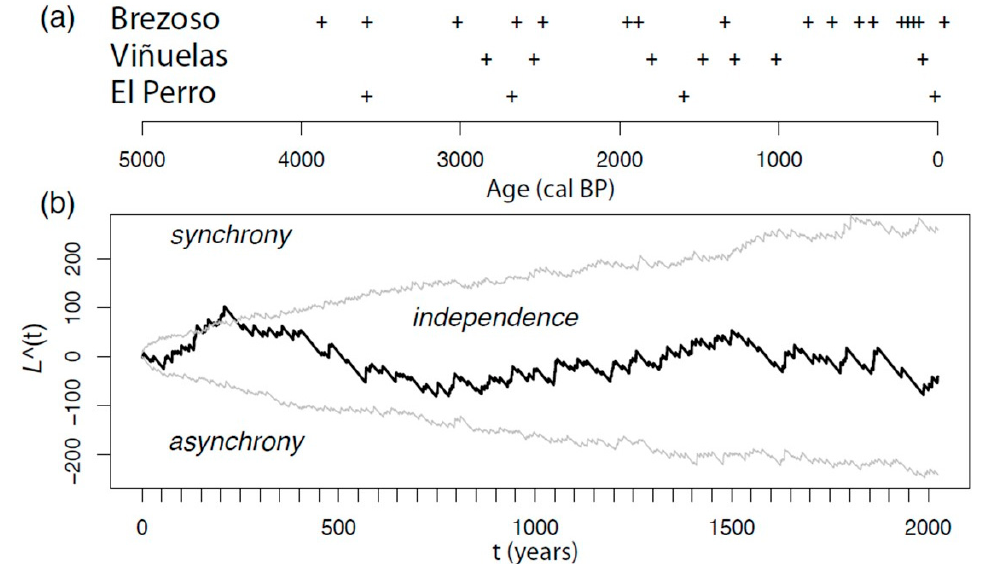
Figure 4. Fire synchronicity. ( a ) Timing of fire events in the three records. “+” denotes statistically robust fire events. ( b ) The L-function (transform of the K-function) for the events in (a) with 95% confidence envelope (thin grey lines) based on 1000 randomizations. The function exceeds the upper confidence envelop from 150 to 250 years, indicating strong correlation of event times within windows of that scale, but lack of long-term patterns in the three records for longer windows, i.e., independence in fire occurrence.